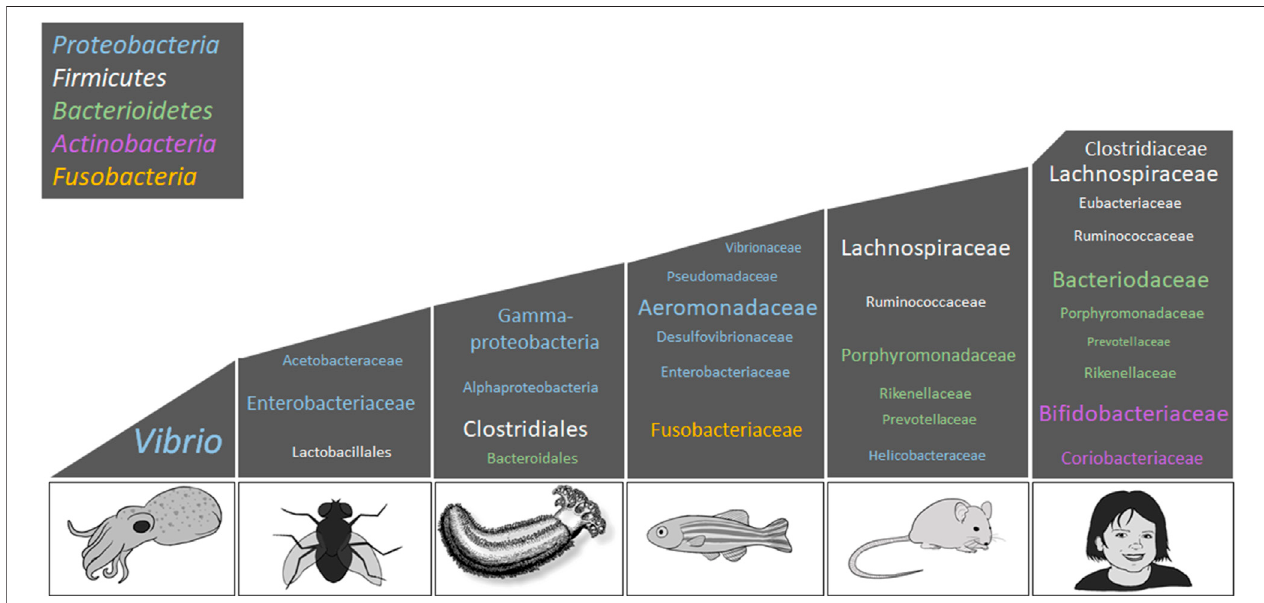
FIGURE 4 | Bacterial composition associated with animal hosts. This scheme presents the most representative taxa among the microbiota of E. scolopes , D. melanogaster , H. glaberrima , D. rerio , M. musculus , and H. sapiens; however, relative representation of these taxa may vary per individual. Top phyla among the animal kingdom includes Proteobacteria (blue), Firmicutes (white), Bacteroidetes (green), Actinobacteria (lilac), and Fusobacteria (yellow). The font size represents the relative abundance of the lower taxonomic levels. This fi gure is an adaptation of Kostic et al. (2013), and contains information from the following studies: Arumugam et al. (2011), Brinkman et al. (2011), Chandler et al. (2011), Roeselers et al. (2011), and Pagán-Jiménez et al. (2019). Images are original drawings by LD-D and